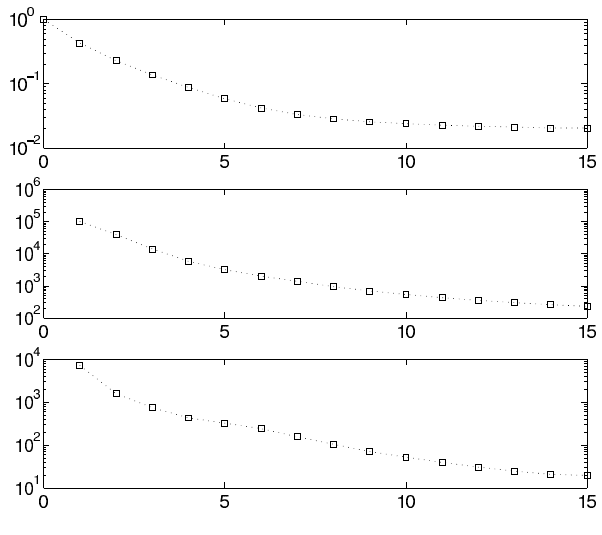
Fig. 2. The decrease with iteration number n of the following quan- tities in the SK case: normalized force imbalance f n (top); cumula- tive ψ change between consecutive iterations (middle); and cumu- lative α change between consecutive iterations